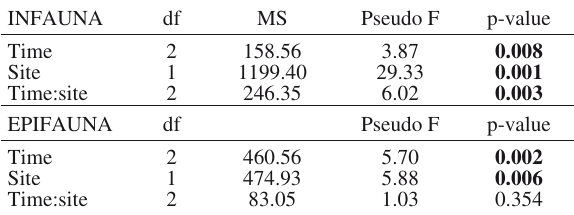
Fig. 4. – A) Evolution of red mullet catches over the years. B) Zoom from November 2001 to October 2005. Pie charts show the percentage of landings and income of red mullet (black area) with respect to total landings and income, respectively (grey area). C) Landings of Mullus barbatus (stripped line) and Squilla mantis (dotted line), and fishing effort (grey continuous line) over the study period (2003-2004). Table 3. – Infauna and epifauna PERMANOVA results for the fixed factors time and site. Significant p-values are highlighted in